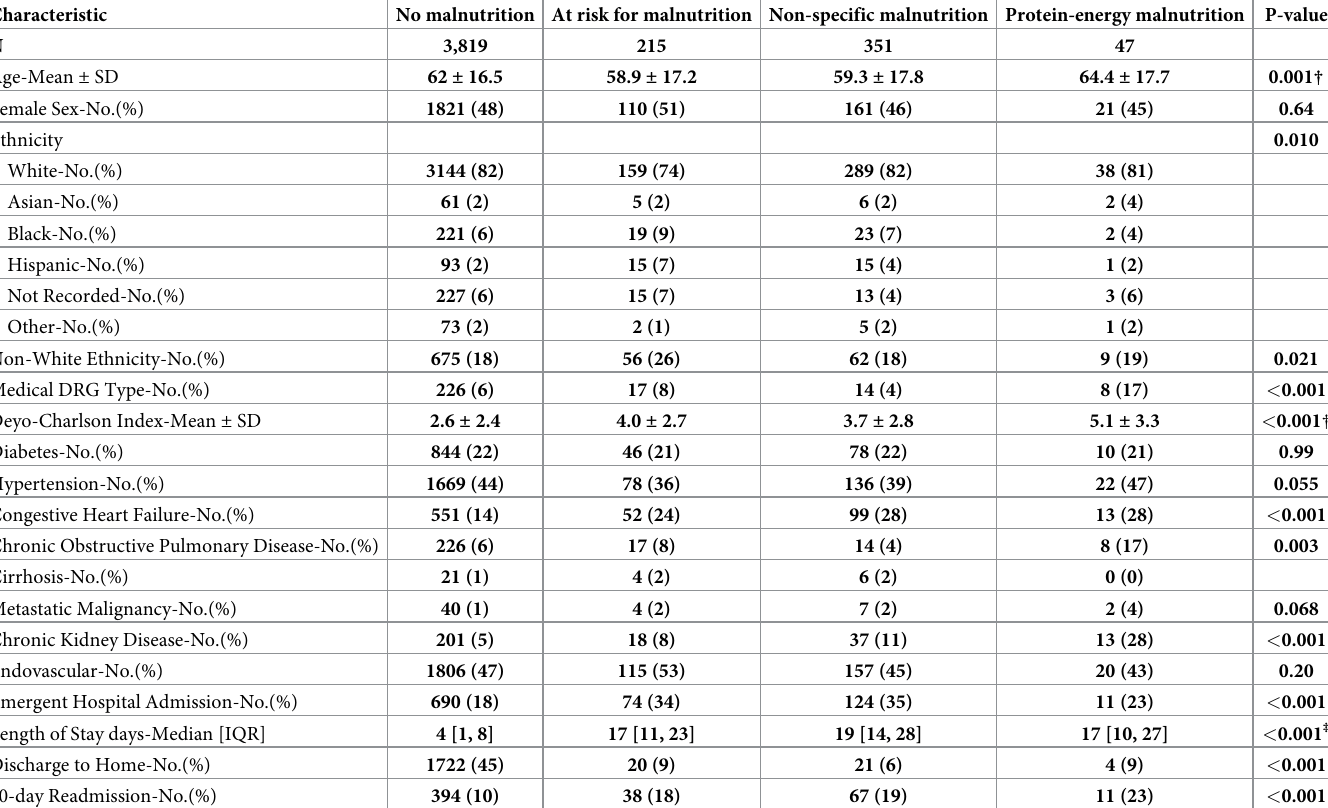
Table 2. Characteristics of the study cohort stratified by nutritional status (n =